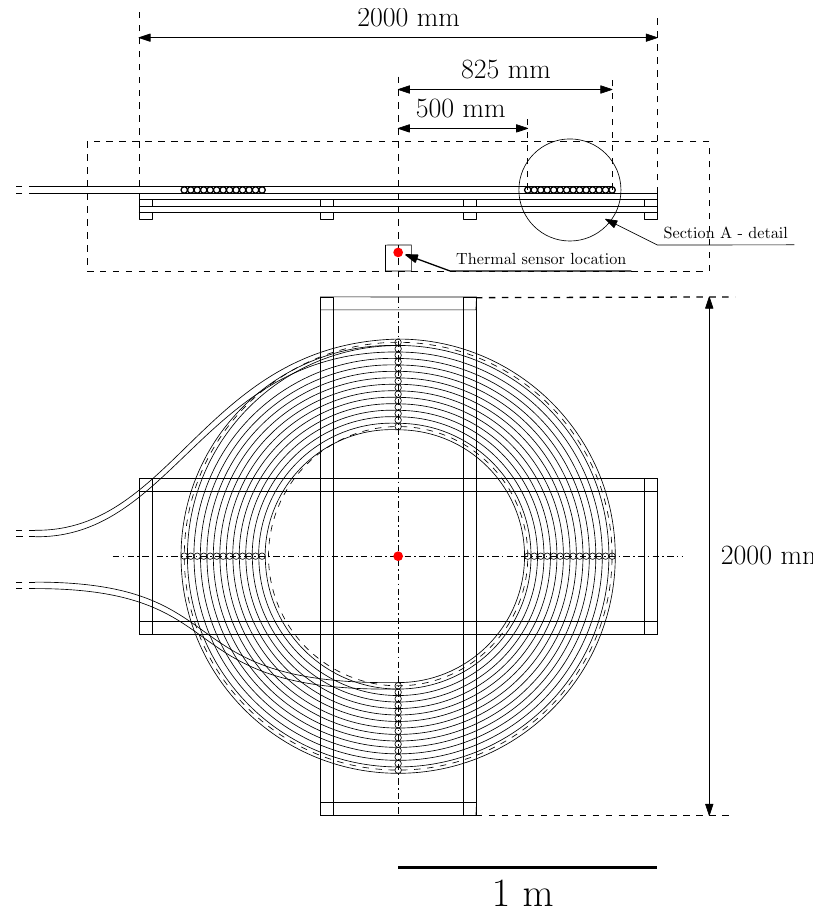
Figure 2. A condenser-type Heat Exchanger mounted on a wooden structure allowing airflow underneath the pipe spiral.